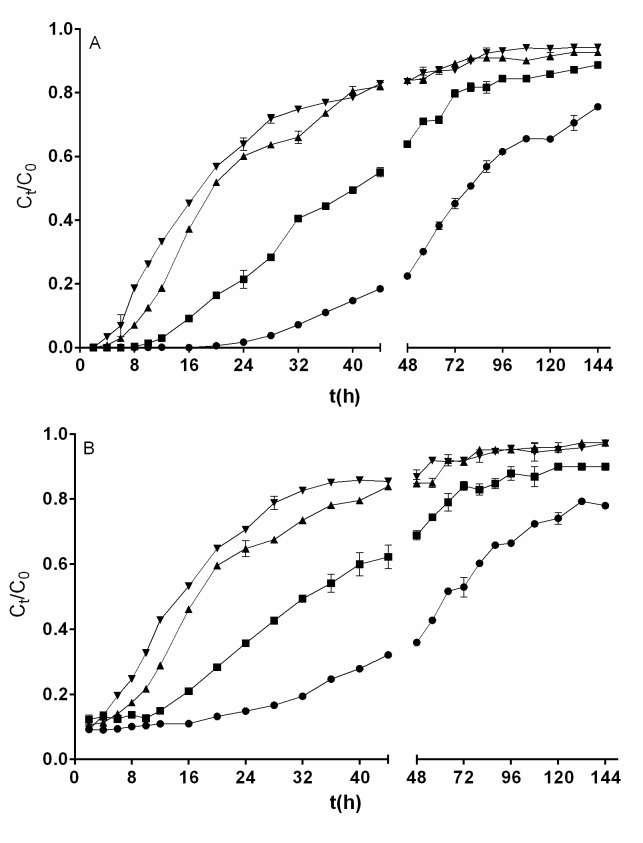
Influence of influent flow rate on the breakthrough curve for removal of Cr(VI) (A) and total chromium (B) by QCS [flow rate (mL min-1): ●, 0.25; ■, 0.5; ▲, 0.75; ▼, 1.0]. Conditions: influent Cr(VI) concentration, 200 mg L−1; bed height, 3.5 cm; solution pH, 2.0. When they do not appear, standard deviation bars are smaller than the size of the symbols.